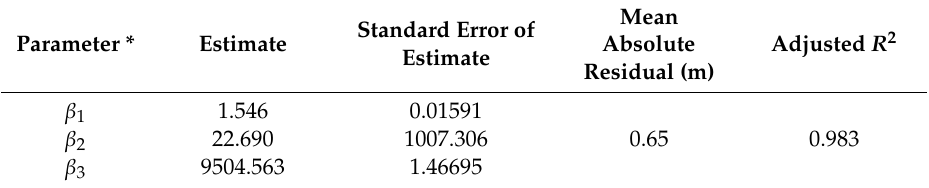
Table 3. The results of parameter estimation using a nested iterative procedure and fitting characteristics of the site index model developed using TSP plot data.